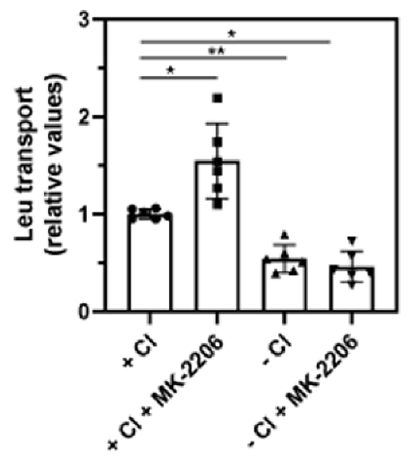
Figure 9. Leucine transport in MCF7 cells. Transport of [ 3 H]leucine was measured for 10 min, as described in Section 3.5, either in PBS (+Cl) or in gluconate solution ( − Cl), with or without 30 min treatment with MK-2206, where indicated. The results of 6 independent measurements with different cell cultures are shown. * p < 0.01, ** p < 0.05.